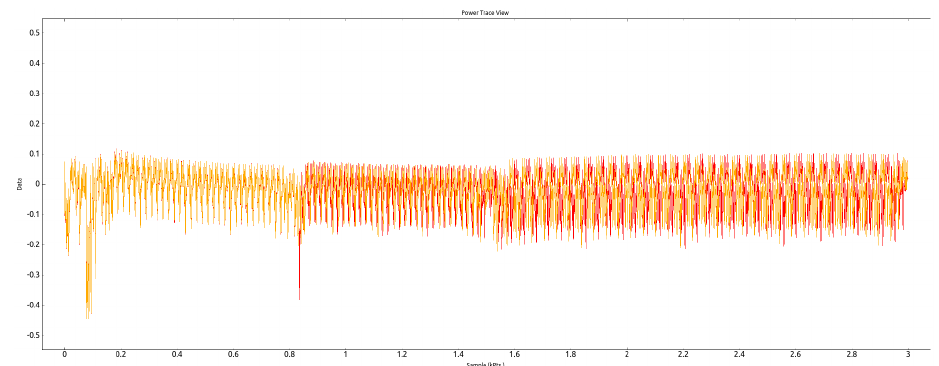
Figure 3: Power trace of the device starting from the call to ladder_base : correct execution (orange) and faulty one with glitch at offset 202 (red). Sampling rate is 4 × the clock